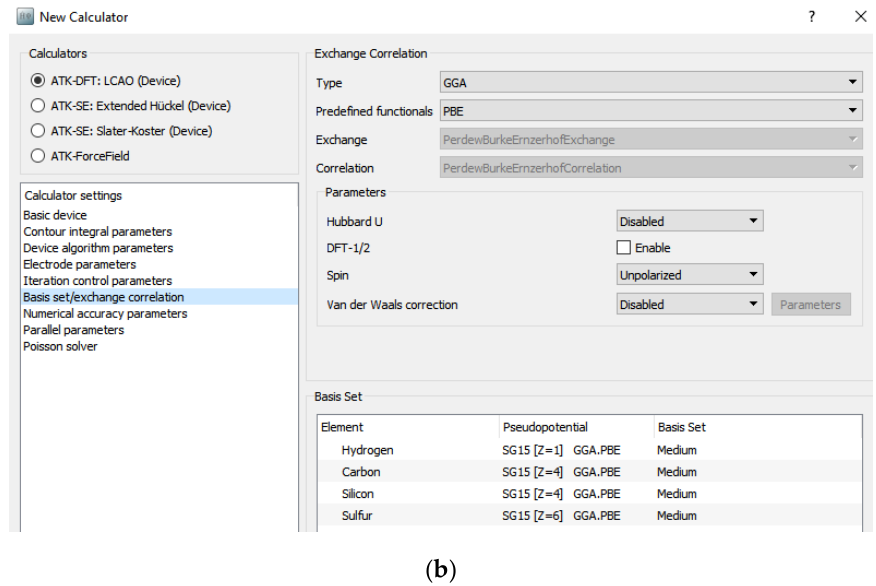
Figure 2. ( a ) Workflow of ATK-VNL software package for the simulation of nanoscale devices; ( b ) Basis set and exchange correlation details for the simulated devices .